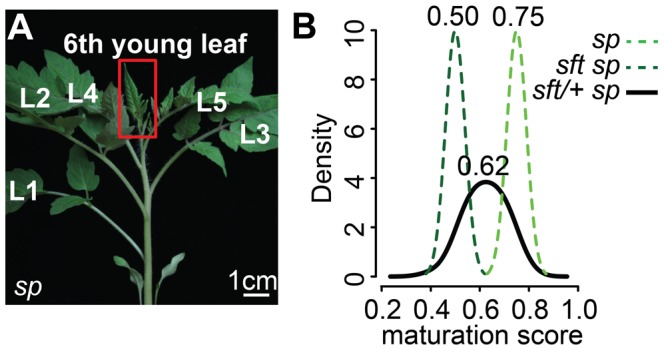
Transcriptome profiling reveals an early semi-dominant delay on seedling development from sft/+ heterozygosity.(A) Representative 6th expanding leaf from sp mutants. The same leaf and stage (3 cm long) was profiled by RNA-Seq for sft/+ sp and sft sp genotypes. (B) Molecular quantification of leaf maturation using the DDI algorithm [31]. Given that seedling development of sft sp is delayed compared to sp based on extreme late flowering, the sft sp 6th expanding leaf was designated an early leaf calibration point. Dark and light green curves indicate sft sp and sp maturation score distributions based on 124 DDI-defined marker genes. The black curve for the sft/+ sp 6th leaf indicates an intermediate maturation state. Numbers above indicate average maturation scores.